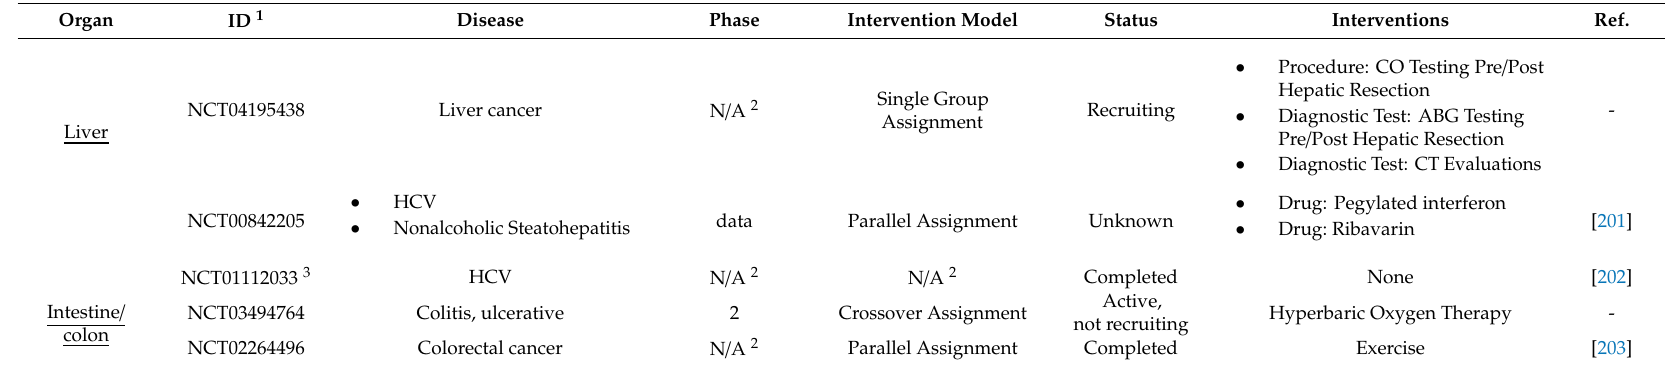
Table 2. Clinical trials in which HO-1 expression is evaluated as a predictor of disease outcome.